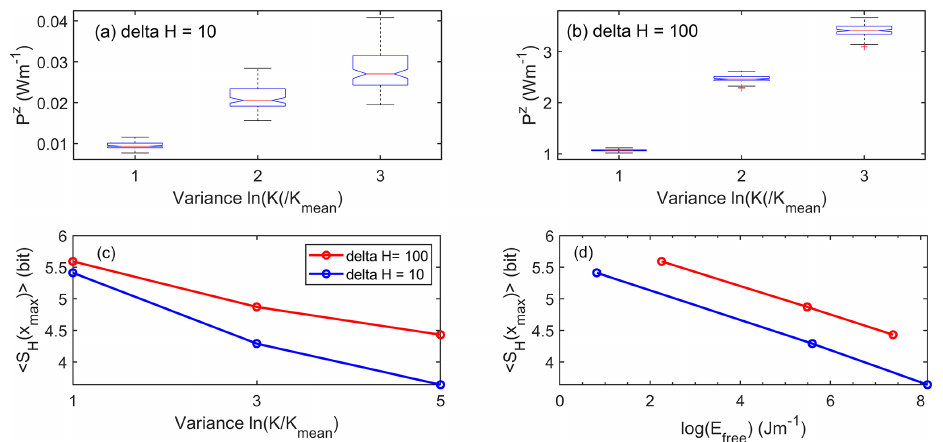
Figure 5. Boxplots of the power in the vertical flow component P z as a function of the variance in ln( K) for the head differ- ence (a) (cid:49)H = 100m and (b) (cid:49)H = 10m. The corresponding median flow path entropy of the ensembles at the domain outlet is plotted as a function of the variance of ln( K) (c) and against the median work E free performed by the fluid. The latter is power times the maximum travel time to the outlet.